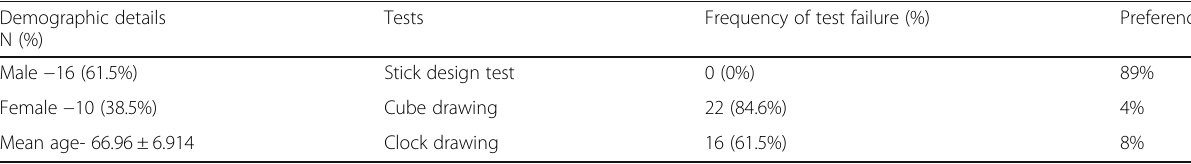
Table 3 Results of preference